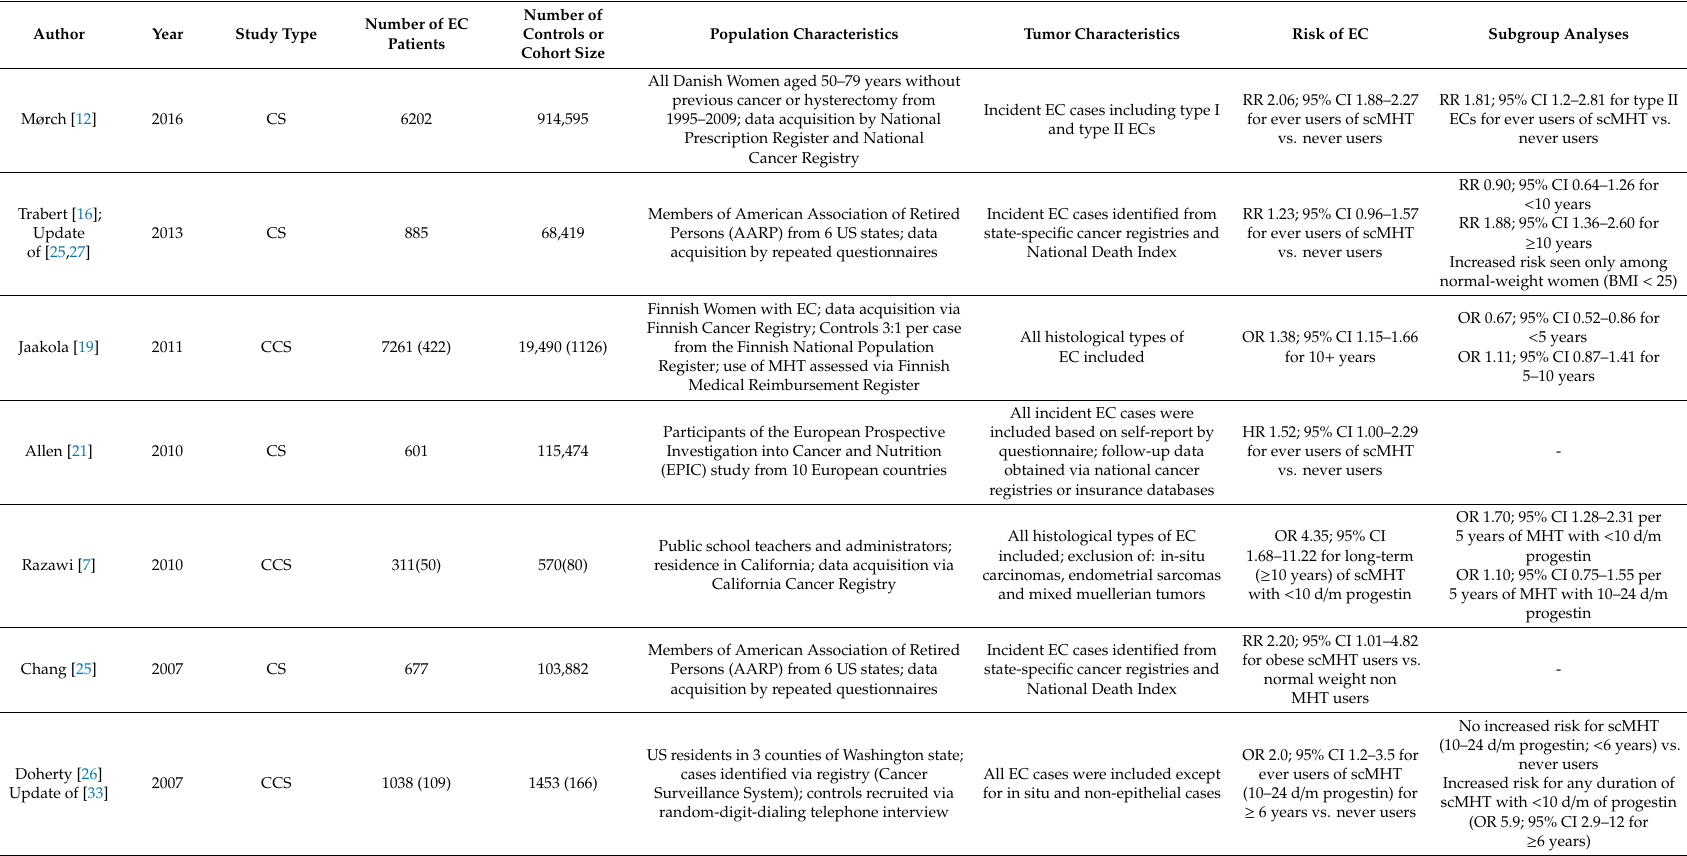
Table 2. Clinical Characteristics of Studies Reporting on scMHT with Synthetic Progestins and EC